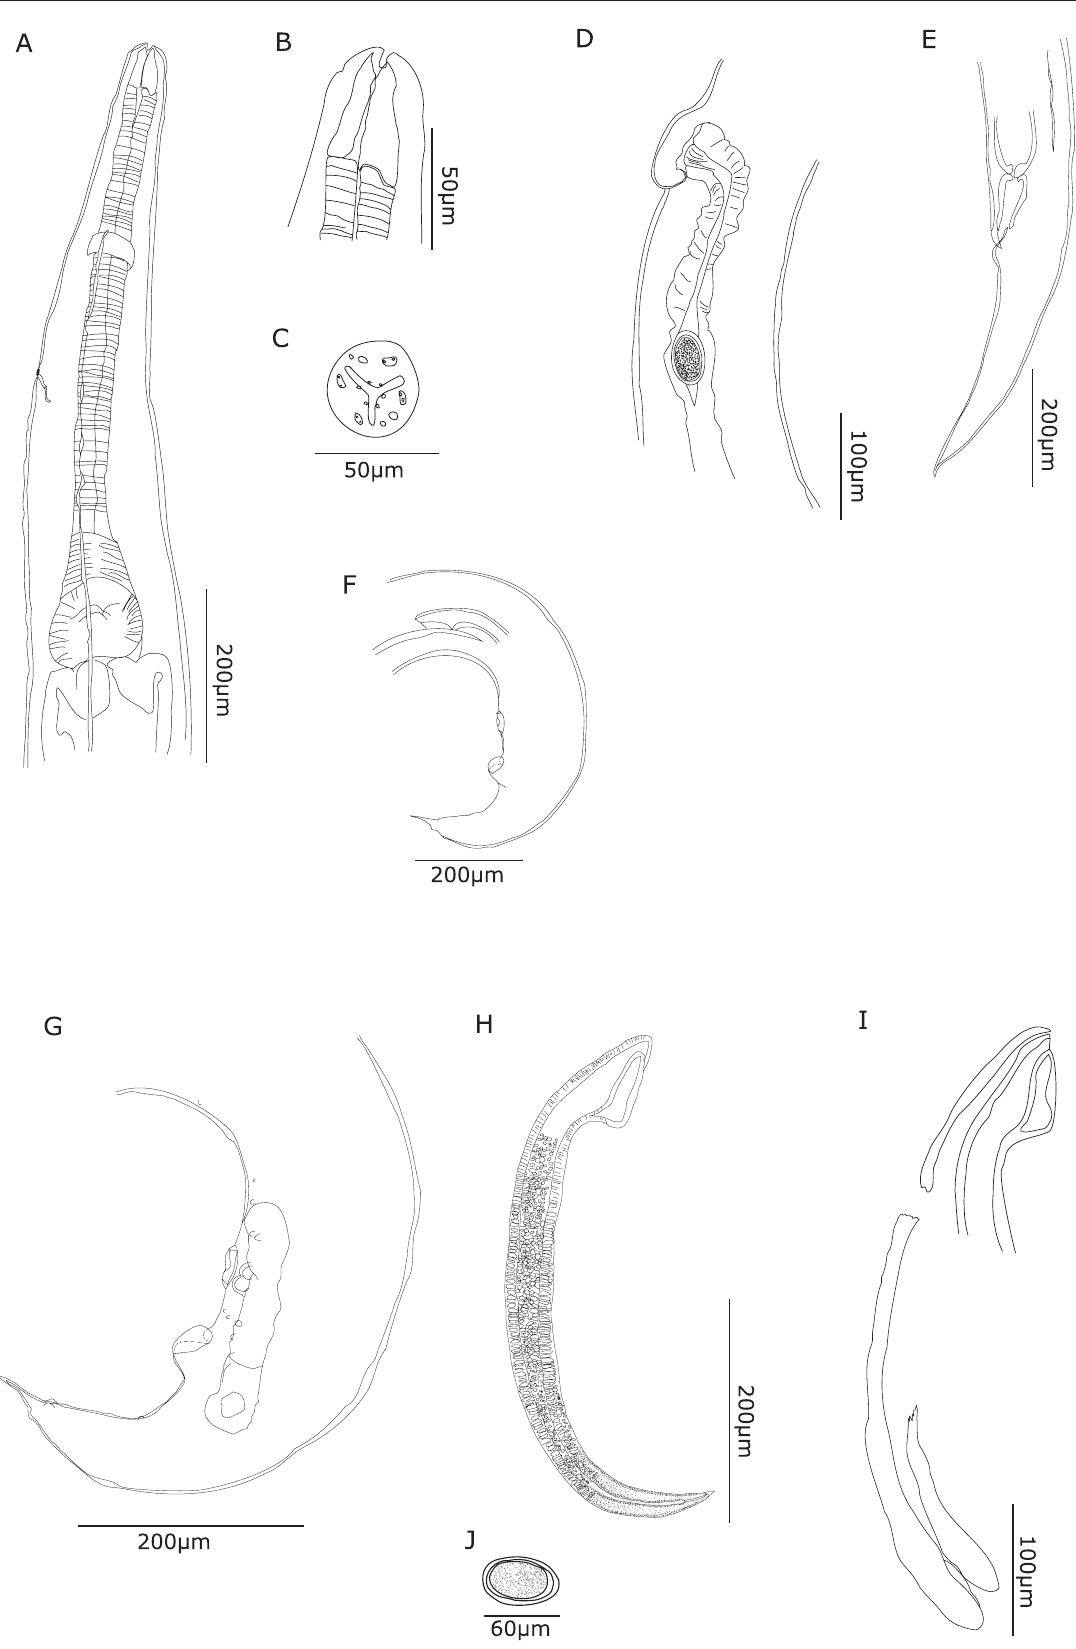
Figure 2. Meteterakis formosensis sp. n., holotype (KUZ Z1779: A , B , F , G ), paratypes (KUZ Z1781: D , J ; KUZ Z1782: E ; KUZ Z1994: H , I ; KUZ Z1995: C ). A anterior region, lateral view; B pharynx, lateral view; C anterior end, apical view; D vulvar area of female, lateral view; E caudal region of female, lateral view; F caudal region of male, lateral view; G caudal papillae arrangement of male, lateral view; H spicule; I accessory of spicule; J